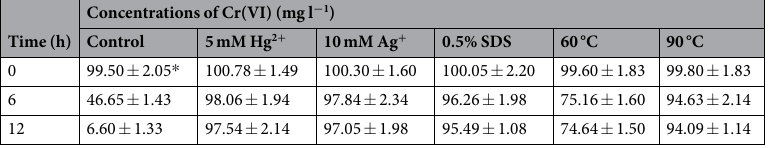
Table 3. The Cr(VI) reducing capability of sludge after heating denaturalization and protein denaturant treatments (25 °C). * Represents standard deviation